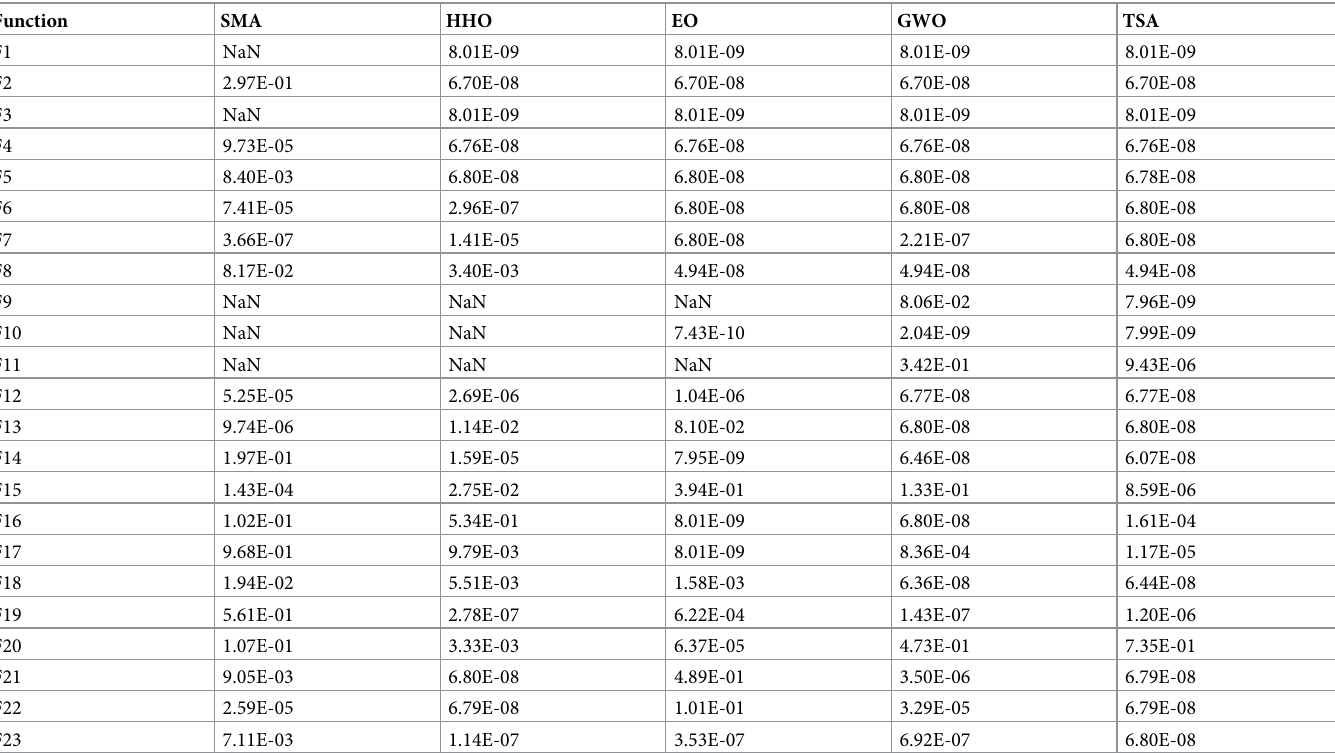
Table 8. Comparison results on Wilcoxon rank sum test with algorithms.